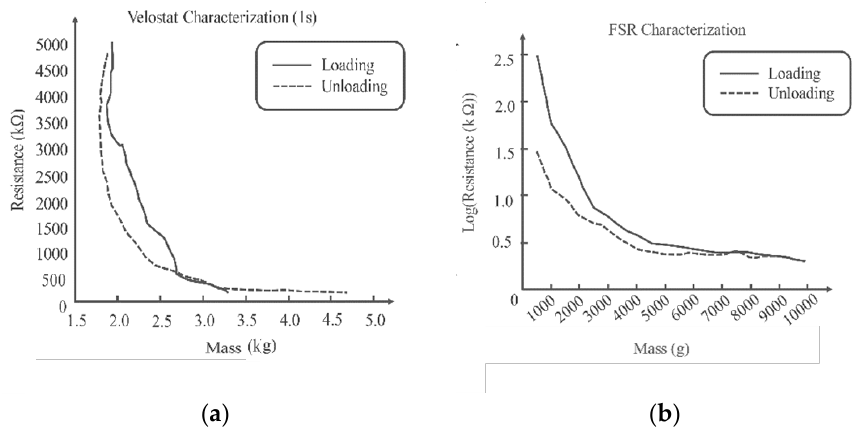
Figure 10. Characterization of the Velostat ( a ) and FSR ( b ).